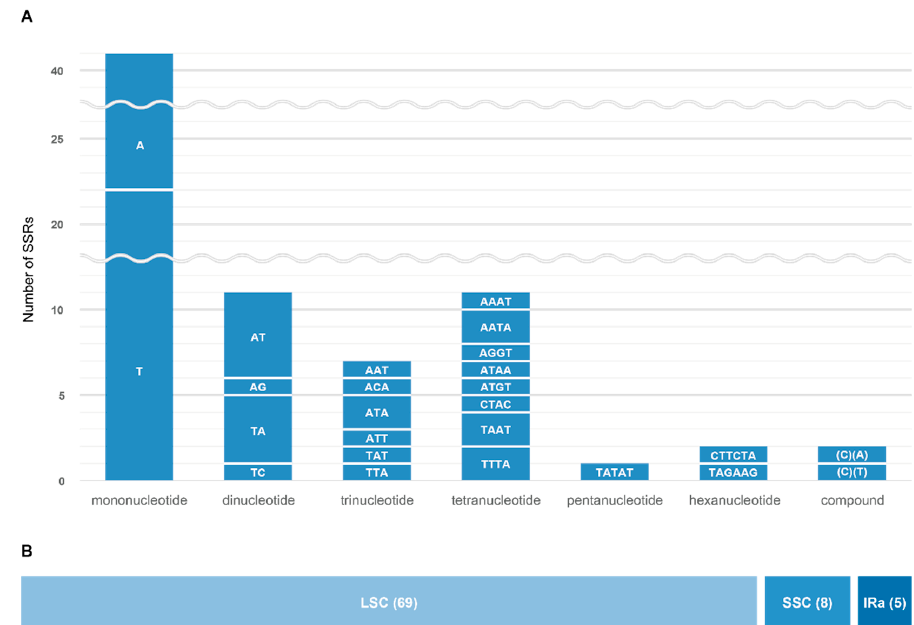
Figure 7. Information of simple sequence repeats (SSRs) of the Synstylae chloroplast genomes. ( A ) SSR types and the number of different SSR types. Each repeat motif is indicated in the middle of each bar. ( B ) The proportion of SSR location in the Synstylae chloroplast genomes. The locations and SSR numbers were indicated in the middle of bars.